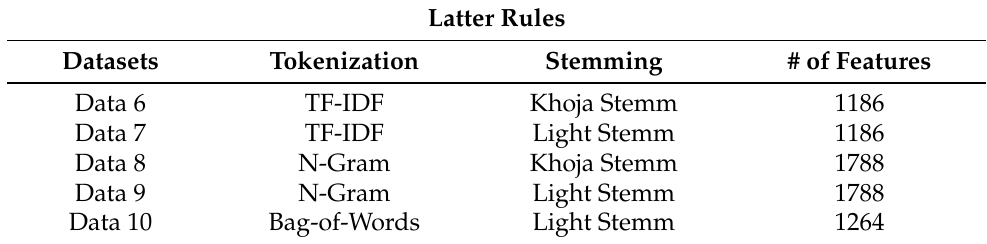
Table 2. The description of the latter rules